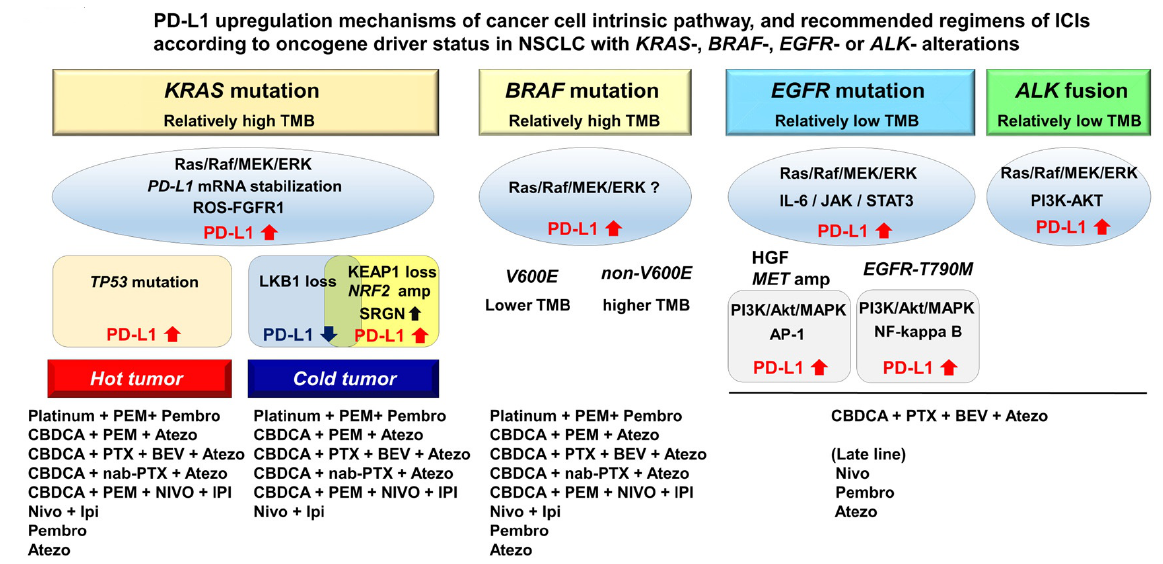
Figure 1. Mechanisms of PD-L1 upregulation of cancer cell intrinsic pathways and recommended ICI regimens based on oncogene driver status in NSCLC with KRAS -, BRAF -, EGFR -, or ALK - alterations. immune phenotype. NSCLC with Kirsten rat sarcoma viral oncogene homolog (KRAS) or B-Raf Proto-Oncogene (BRAF) mutations have a higher TMB, whereas NSCLC with